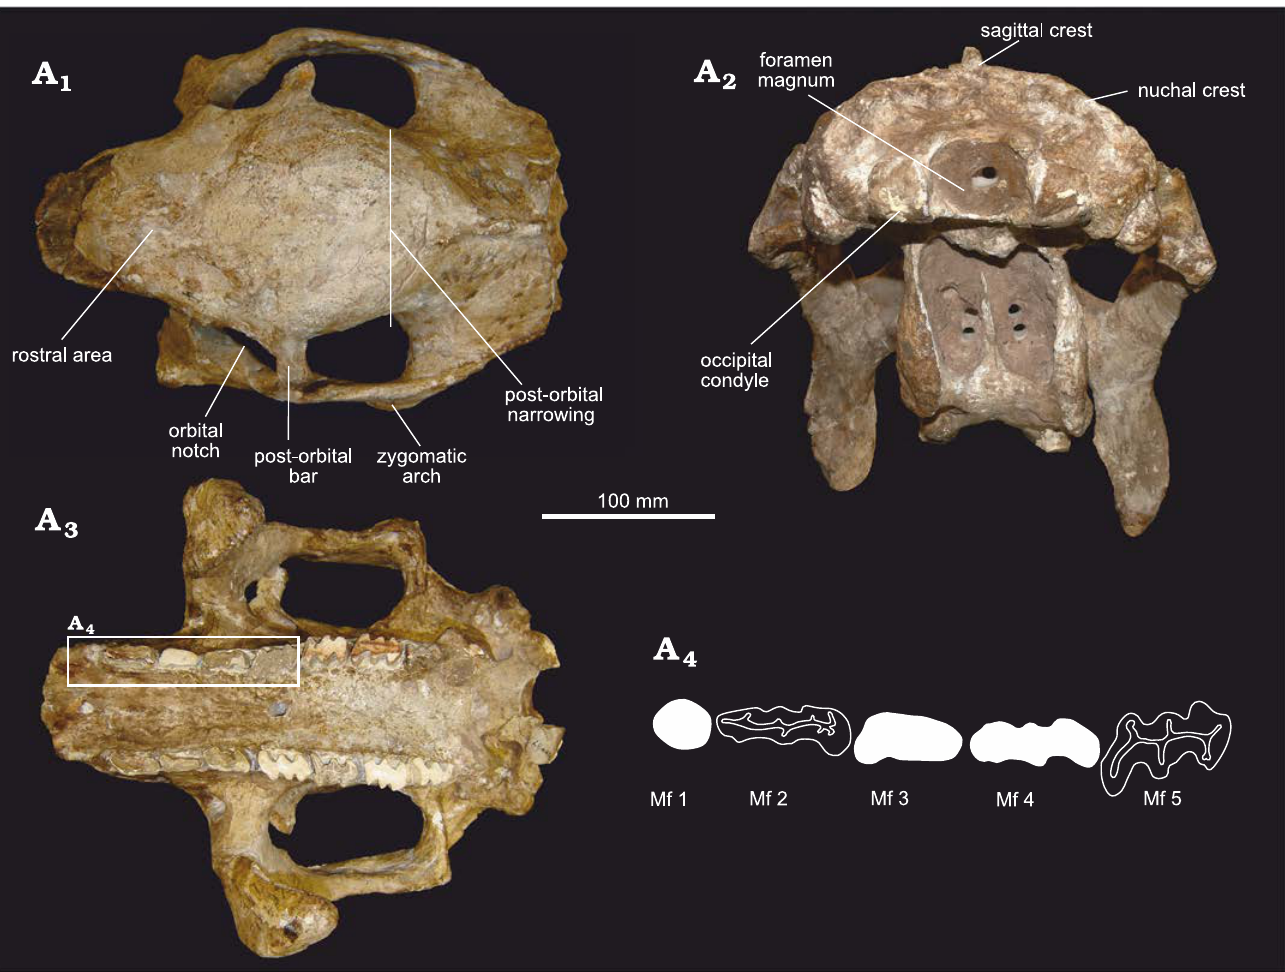
Fig. 4. Skull of doedicurine glyptodont Eleutherocercus solidus (Rovereto, 1914), FMNH-P 14437, from the late Miocene–early Pliocene of Argentina, Puerta de Corral Quemado, Andalhuala Formation, levels 23–28, Argentina; in dorsal (A 1 ) and occipital (A 2 ), and (A 3 ) occlusal views; drawing of detail of the first five molariforms (A 4 ). In white teeth the occlusal surface is covered by